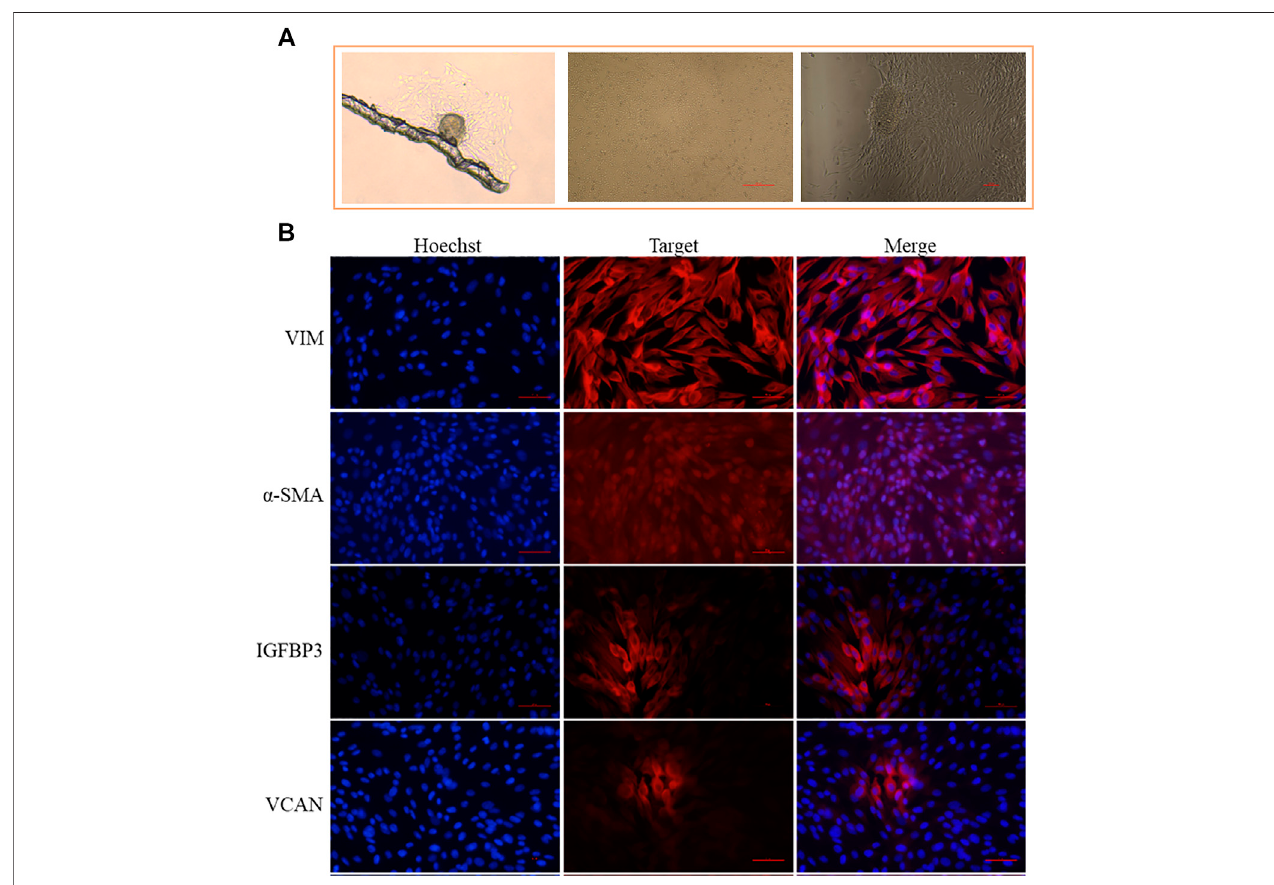
FIGURE 3 | Application of identi fi ed marker genes on DPCs isolated in vitro . (A) Isolated DPCs exhibit a multilayer aggregative growth character. (B) Immuno fl uorescence analysis of VIM, α -SMA, IGFBP3, and VCAN expression in the isolated DPCs. Scale bars, 50 μ m. Red fl uorescence indicates the nuclear expression pattern of target protein. Nucleus was stained with Hoechst in